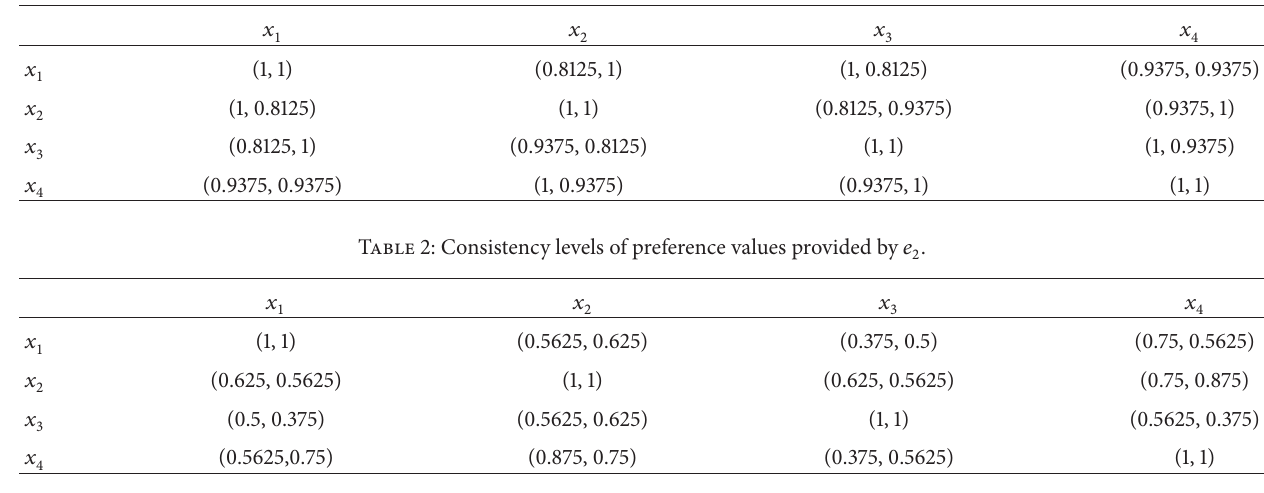
Table 1: Consistency levels of preference values provided by 𝑒 1 .